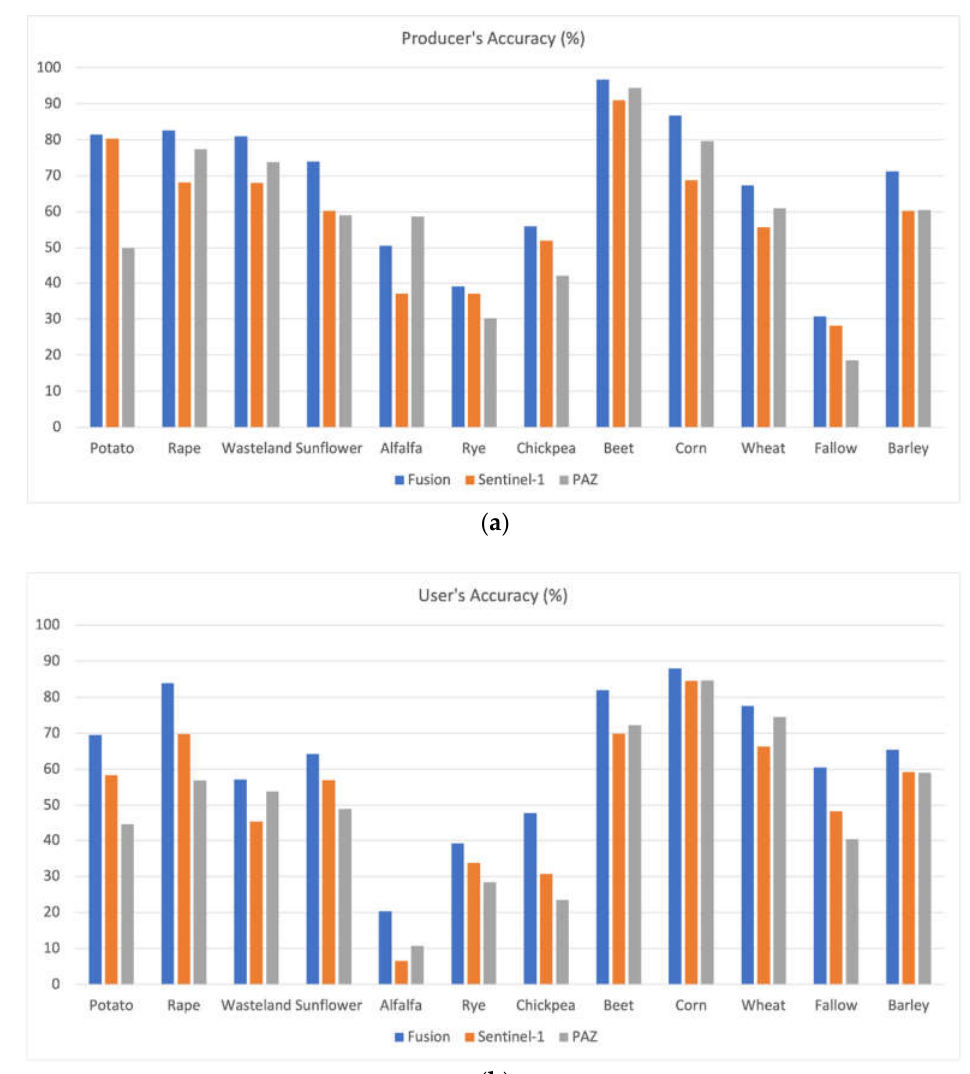
Figure 4. PA and UA bar charts with eight Sentinel-1 and eight PAZ images, both independently and with fusion. ( a ) Producer’s accuracy. ( b ) User’s accuracy. ( a ) Producer’s accuracy. ( b ) User’s